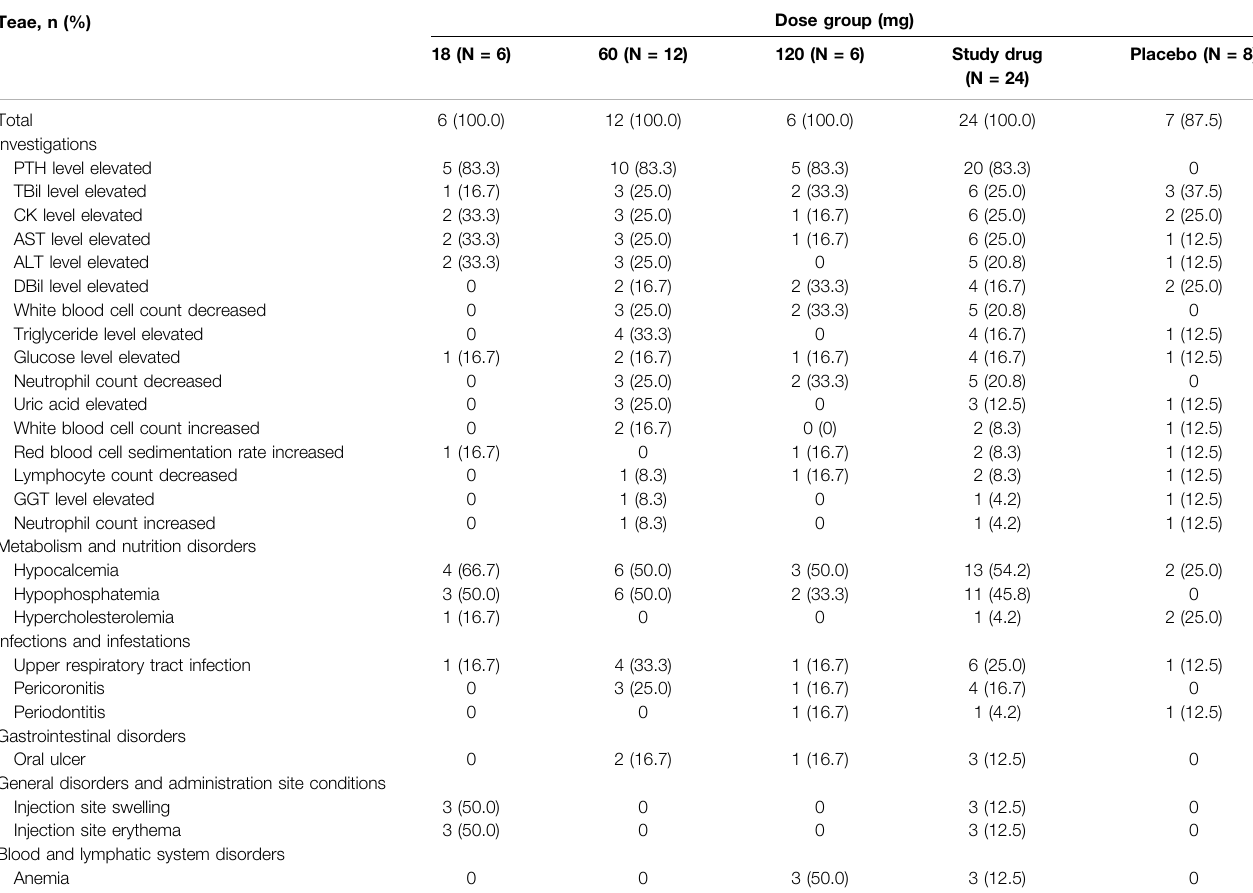
TABLE 3 | Common treatment-emergent adverse